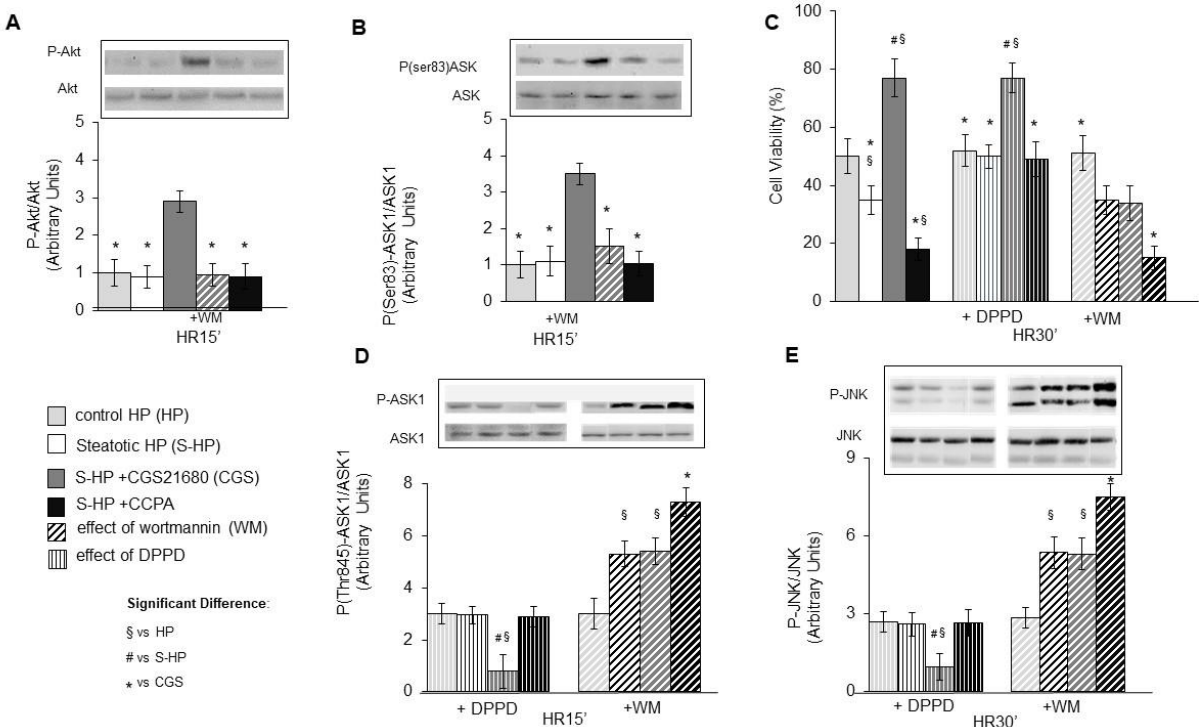
Figure 3. Inhibition of OS production or of PI3K/Akt activation in steatotic HP treated with A2AR or A1R agonist and exposed to H/R: effect on viability, on activation of Akt, ASK1 and JNK and on inhibition of ASK1. Control (HP) and steatotic hepatocytes (S-HP) pre-exposed or not to the A2AR agonist CGS21680 (5 µM) or to the A1R agonist CCPA (100 µM), in presence or absence of the antioxidant DPPD (5 μ M) or of the PI3K/Akt inhibitor wortmannin (WM, 5 nM), were stored at 4 °C for 8 h in hypoxic VIASPAN solution added (S-HP) or not (HP) with palmitic acid (PA, 50 μ M) and then reoxygenated at 37 °C for 30 min. ( A ) Akt activation. ( B ) ASK1 inhibition, ( C ) Cell viability, ( D ) ASK1 activation, ( E ) JNK activation. The different parameters were estimated after 15 or 30 min of reoxygenation (H/R). The results are expressed as mean of 3 – 5 experiments ± SD. Statistical significance: * # § p < 0.05.